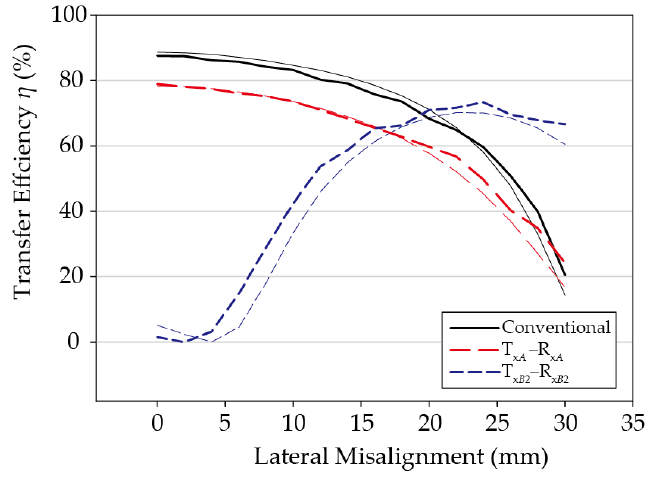
Figure 6. Comparison of the simulated (thin) and the measured (thick) transfer efficiencies be- tween the two multilayer